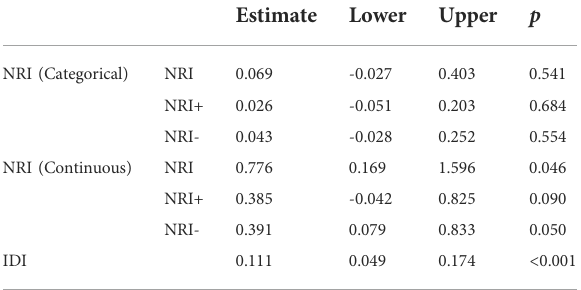
TABLE 3 NRI and IDI differences between the old and new models.